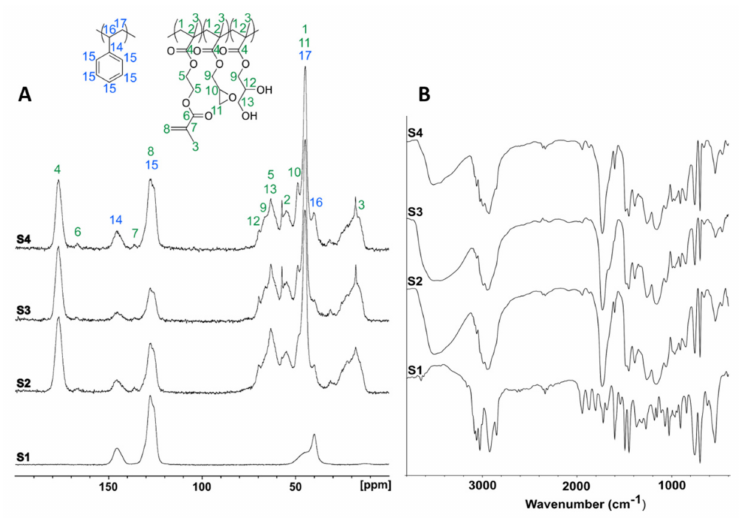
Figure 1. ( A ) Solid-state 13 C CP/MAS NMR spectra of particles S1 – S4 and ( B ) DRIFT spectra of the particles S1 – S4